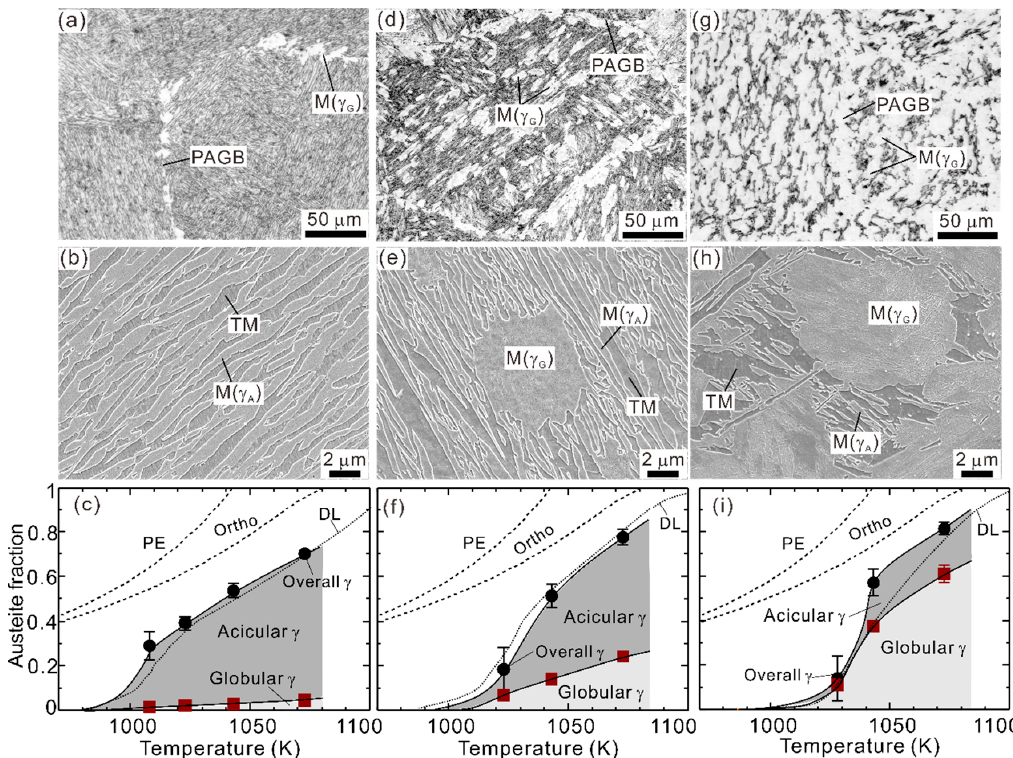
Figure 2. ( a , d , g ) Optical microscopy (OM) and ( b , e , h ) SEM images of the specimen quenched from 1073 K and heated at different heating rates: ( a , b ) 0.1 K/s, ( d , e ) 1 K/s, and ( g , h ) 20 K/s; temperature variation of the fractions of the overall, acicular, and globular γ at heating rates of ( c ) 0.1 K/s, ( f ) 1 K/s, and ( i ) 20 K/s. γ A (M): acicular γ (martensite at room temperature), γ G (M): globular γ , TM: tempered martensite.